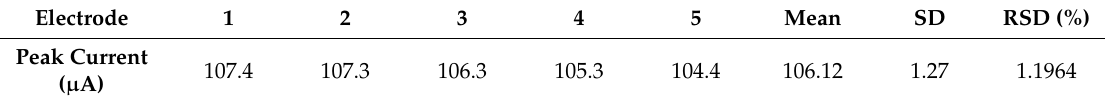
Table 2. Reproducibility of the PANI electrode for sensing